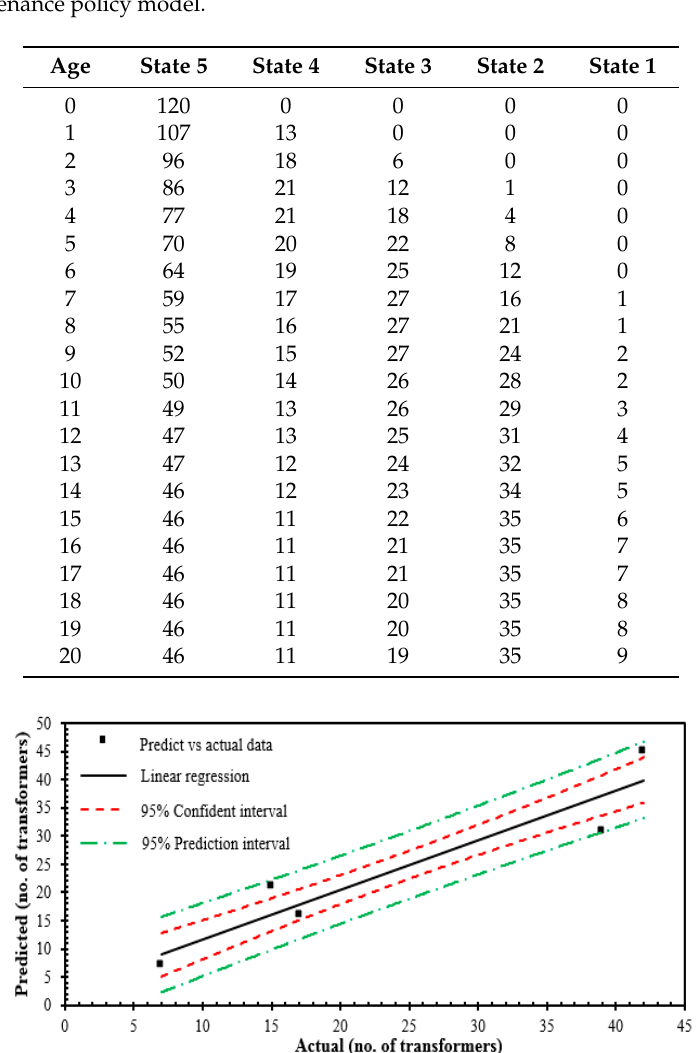
Table 7. Numbers of transformers in each of the states based on transition states for the year 2013/2014 with the maintenance policy model.